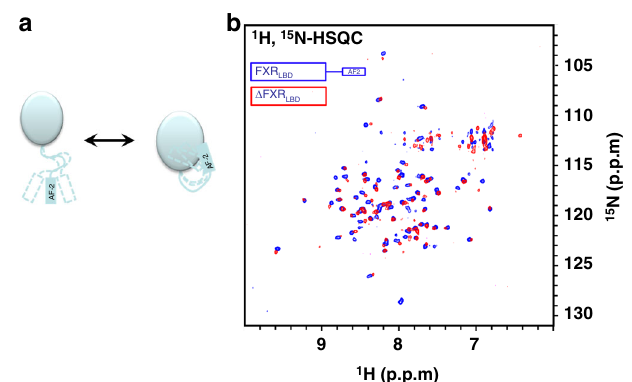
Fig. 6 NMR study on the interaction of α 12 with the FXR-LBD core domain. a Model depicting transient interaction of the AF2 helix with the core domain. b Superimposition of 1 H, 15 N-HSQC of fully 13C/15N-labeled FXR- LBD (blue) and an AF2 truncated FXR-LBD mutant (red) reveals signi fi cant shifts and disappearance of signals indicating that α 12 interacts transiently with the core domain of the FXR-LBD even in the absence of a ligand/